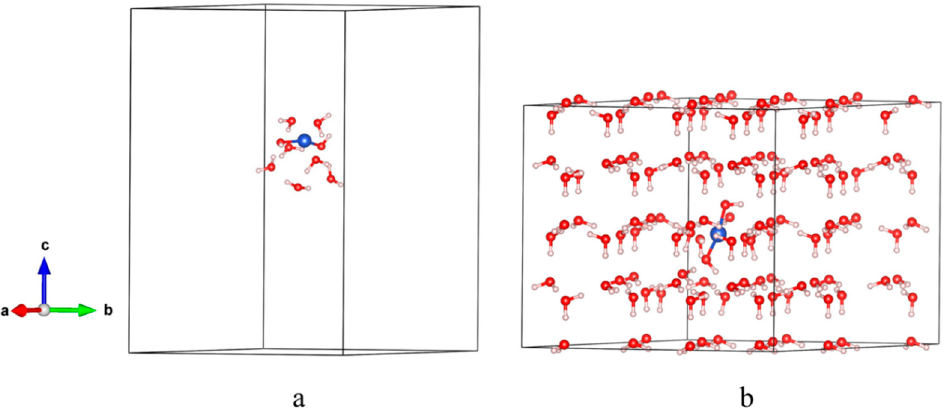
Figure 2. ( a ) The model of Cu 2+ in the aqueous environment. ( b ) The model of Cu 2+ in the ice environment (a represents x-axis, b represents y-axis, c represents z-axis; the blue atom is Cu, the red atoms are O, the grey atoms are H).